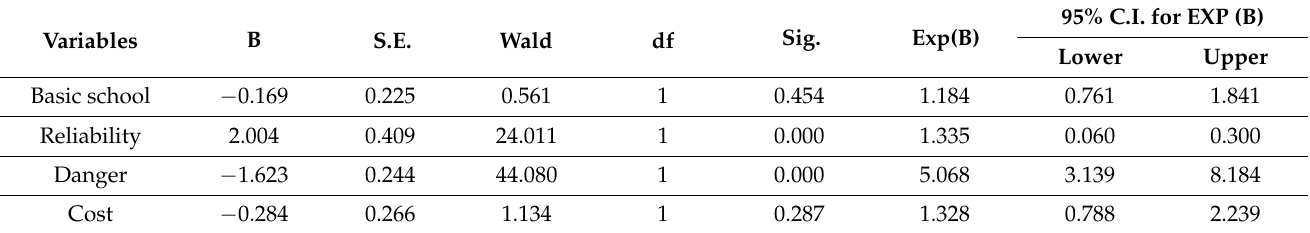
Table 4. Logistic regression with a volition to buy a self-test if needed as a dependent variable.